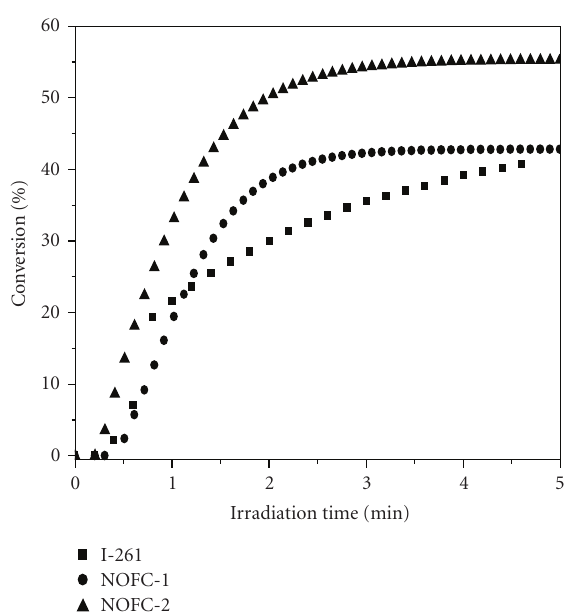
Scheme 2: Synthesis of NOFC-2.